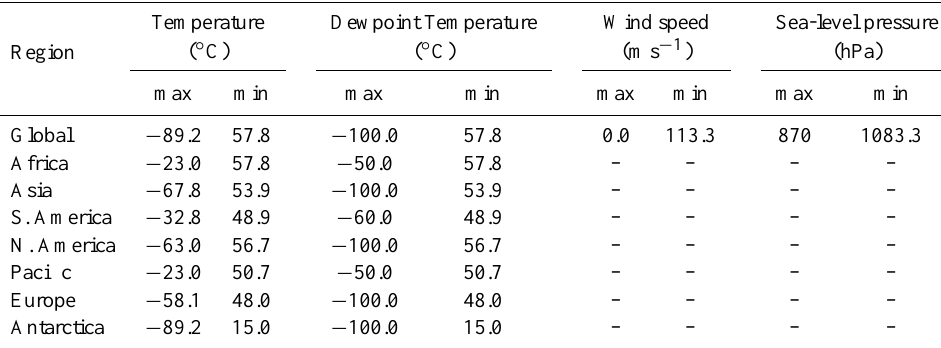
Table 3. Extreme limits for observed variables gained from http://wmo.asu.edu (the official WMO climate extremes repository) and the GHCND tests. Dewpoint minima are estimates based upon the record temperature minimum for each region. First element in each cell is the minimum and the second the maximum legal value. Regions follow WMO regional definitions and are given at: http://weather.noaa.gov/tg/site.shtml. Global values are used for any station where the assigned WMO identifier is missing or does not fall within the region categorization. Wind speed and sea-level pressure records are not currently documented regionally so global values are used throughout. We note that the value for the African and global maximum temperature has changed (El Fadli et al., 2012). This will be updated in a future version of